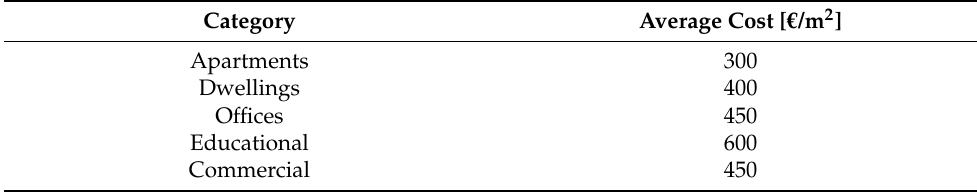
Table 6. Average renovation costs per unit area to class C for all categories